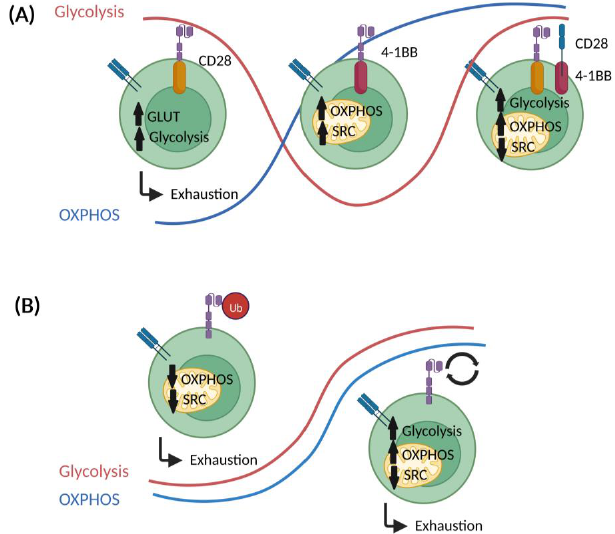
Figure 4. Impact of CAR design on CAR T cell metabolism. ( A ) Co-stimulatory signaling domains (CD28, 4-1BB, CD28+4-1BB) of CARs can impact several metabolic parameters such expression of glucose transporter (GLUT), extracellular acidification rate (ECAR), oxygen consumption rate (OCR) or spared respirator capacity (SRC). ( B ) Ubiquitination (Ub) and tonicity of CARs with im- pact on bioenergetics (and